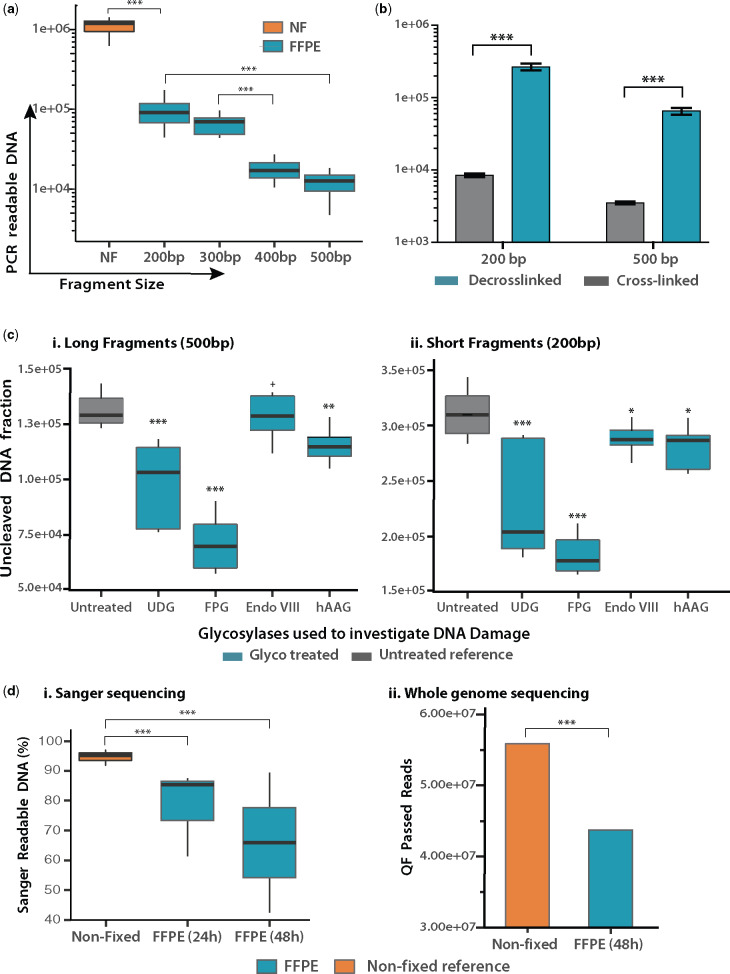
Analysis of bacterial FFPE DNA damage. (a) Measuring fragmentation of PCR-amplifiable DNA. For NF bacteria, amplification of all fragment lengths was equal and grouped in the same box (n = 28). For FFPE bacteria (n = 24 for each box), a linear fragment-length correlation is evident, with a log-decrease observed from NF to FFPE 200 bp fragments and a log-decrease between short (200 bp) and long (500 bp) fragments (P < 0.001). (b) Assessing the extent of cross-links in bacterial DNA. DNA from FFPE blocks containing E. coli cells was subjected (n = 6) or not (n = 6) to a high-temperature cross-link reversal treatment. The bar plot shows the quantity of amplifiable DNA obtained ± cross-link reversal for long and short DNA fragments. Without decrosslinking, only 3–5% of the available DNA template is amplifiable for PCR. (c) Evaluating the presence of damaged nucleotides via glycosylase treatment. Box plots show the quantity of amplifiable DNA post-treatment with the respective glycosylase (n = 6 in all cases). (d) Assessment of DNA sequence quality by sequencing. (i) Sanger sequencing showing the percentage DNA falling within the high confidence read region for each sample. (ii) WGS showing the number of QF pass reads for FFPE and NF bacteria.